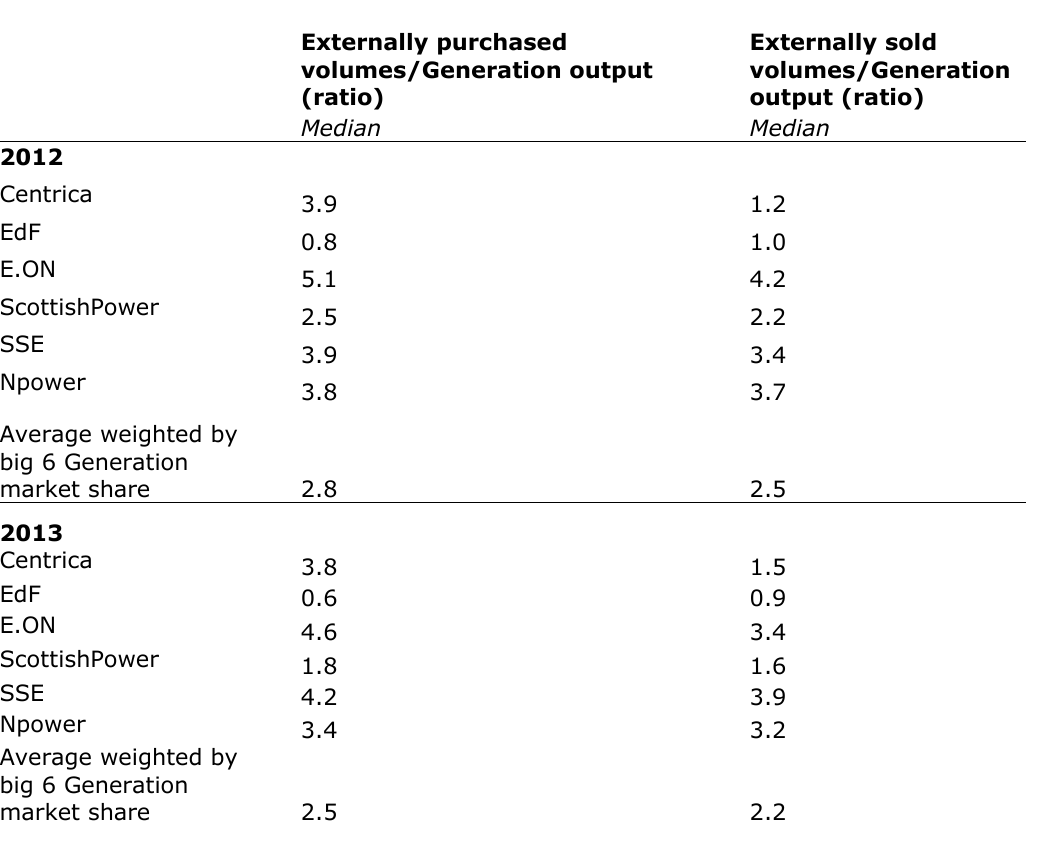
Figure 43: External trading positions of the six largest energy companies